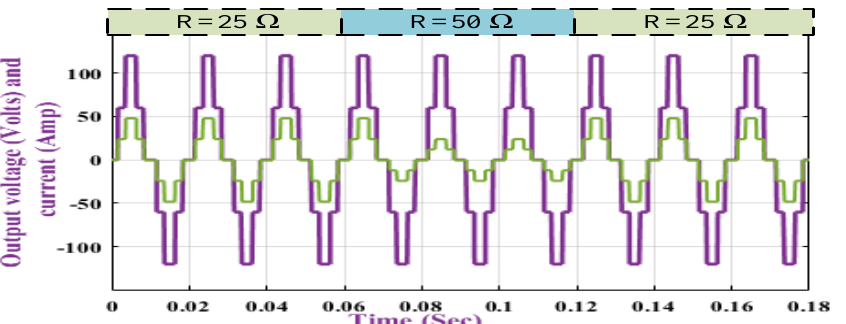
Figure 13. Nine-level outputs and the harmonic profile.